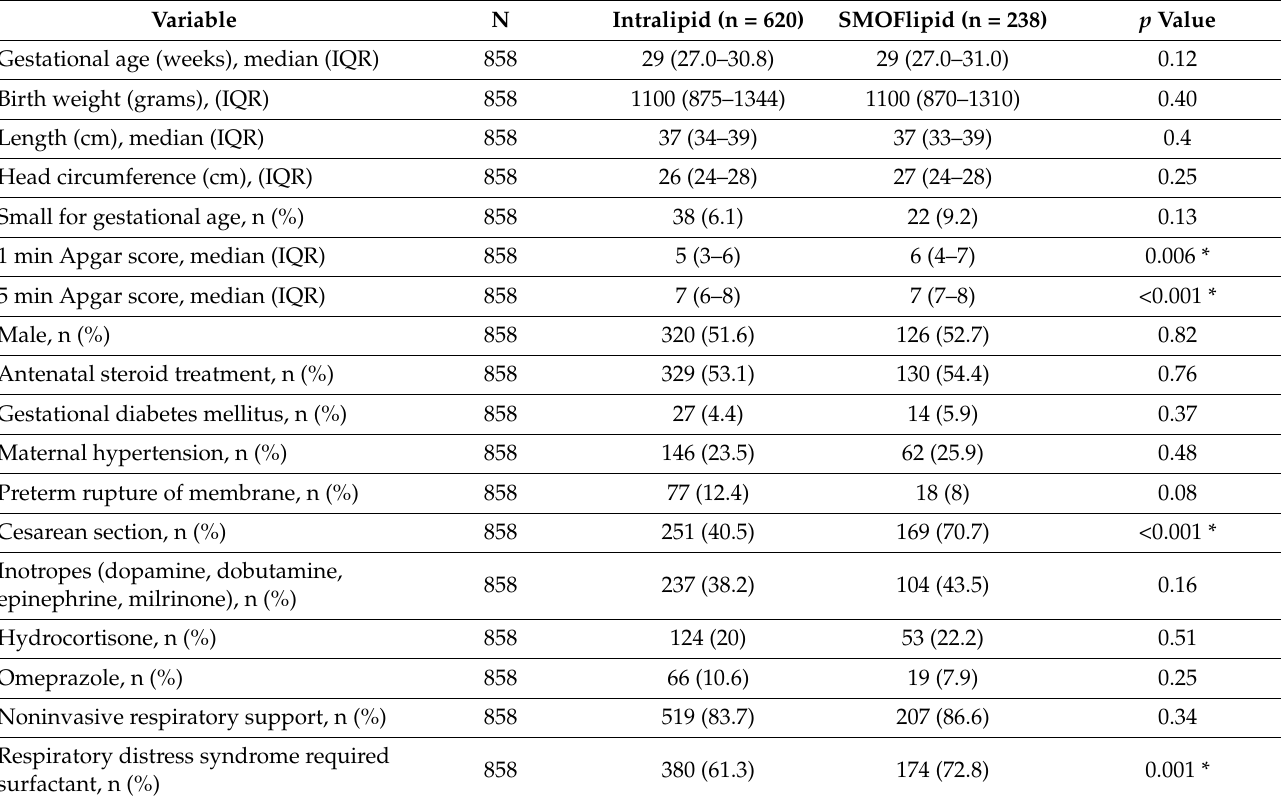
Table 1. Maternal and neonatal characteristics of study participants with SMOFlipid and intralipid.